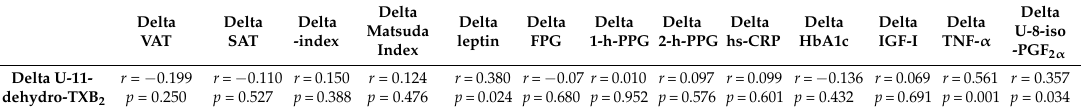
Table 4. Correlations between change in platelet activation and change in glycometabolic variables. Delta